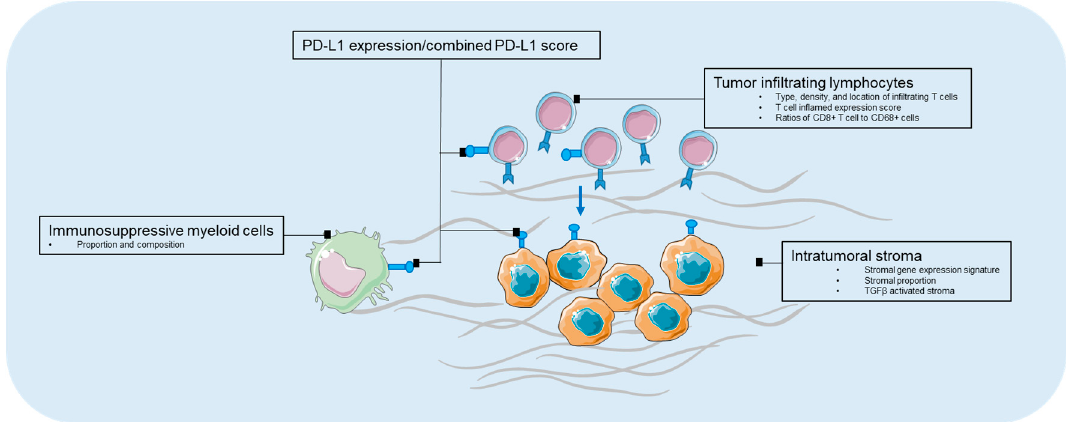
Figure 1. Biomarkers in tumor microenvironment. PD-L1—programmed death-1 ligand-1.